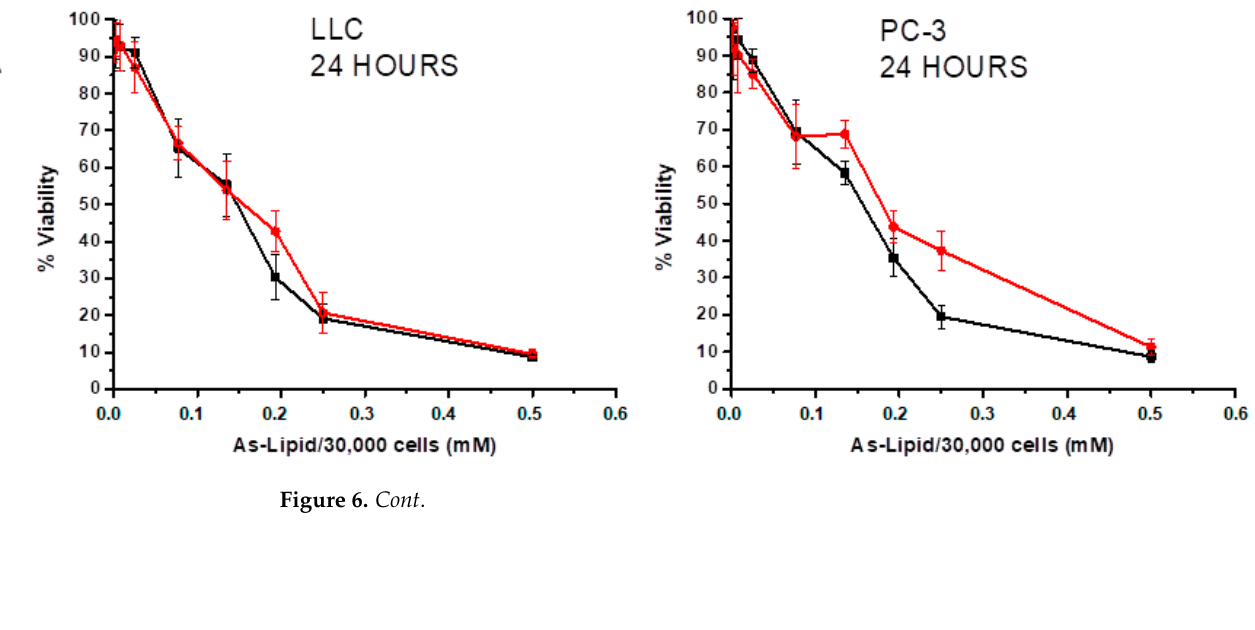
Figure 6. ( Α ) Viability of LLC and PC-3 cancer cells after incubation with As-liposomes for 24 h at high concentrations (up to 0.5 mM As-Lipid/30,000 cells); ( Β ) viability of LLC and PC-3 cancer cells after incubation with As-liposomes for 48 and 72 h at low concentrations (up to 0.08 mM As-Li- pid/30,000 cells). The black line refers to the As-ester-lipid liposomes of type 2 , while the red line refers to the As-ether-lipid liposomes of type 5 .